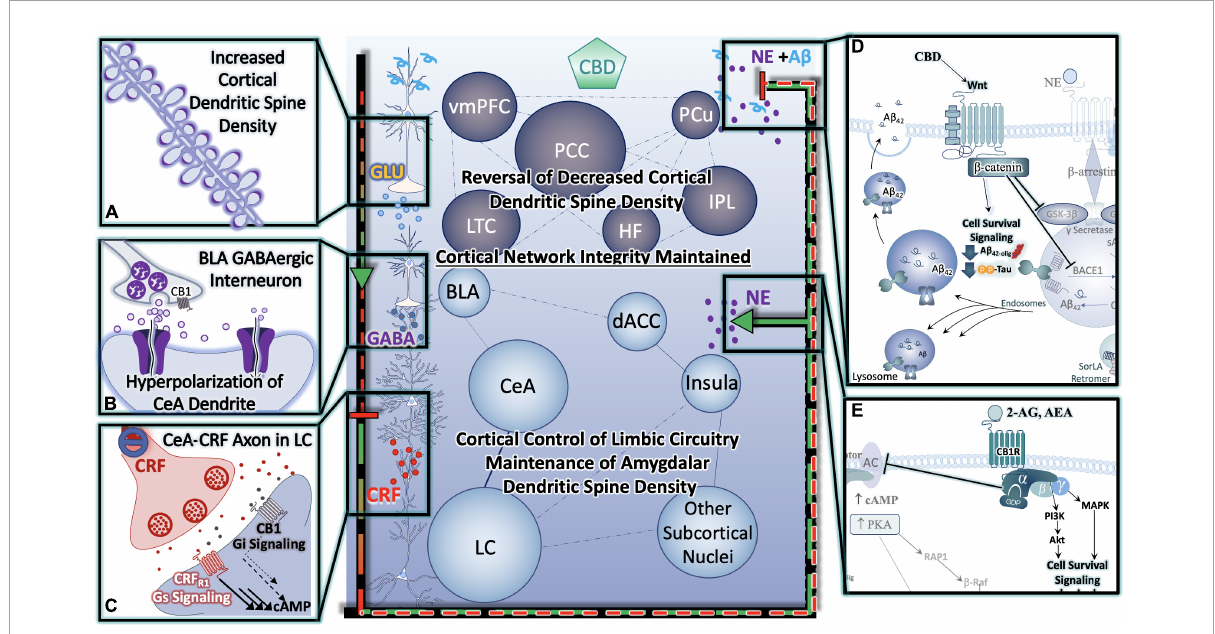
FIGURE4 Cannabinoids Prevent Hyper-Activation of Stress-Integrative Circuitry, Protecting Cortical Network Integrity, Reducing Cellular Stress, Inflammation, Reduce Behavioral Symptoms and Improve Cognitive Function. (A) Cannabinoid-induced reversal of stress-induced dendritic retraction in cortical areas. (B) Cannabinoid-mediated engagement/activation of GABAergic interneurons of the BLA- reduces central drive to the CeA. (C) Cannabinoid-mediated reduction in central drive of the CeA results in downstream reductions in excitatory input to LC neurons, protecting them from consequences of hyperactivation. (D) Cannabinoids (including CBD) protect neurons from (D) Alzheimer’s Neuropathology Neuropathology, and (E) excitotoxicity and/or hyperactivity via G α i signaling [ (D,E) are depicted in greater detail in Figure 6